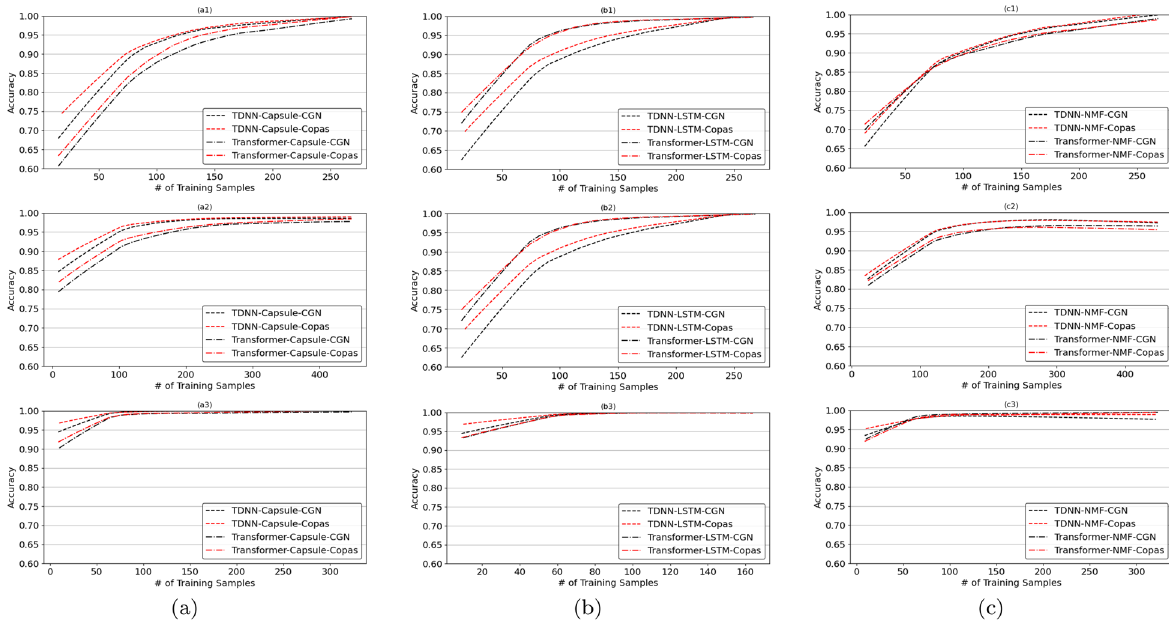
Fig. 9 Average learning curves for different decoders: (a) capsule network, (b) LSTM, (c) NMF. Rows correspond to (1) severely impaired speakers (2) moderately impaired speakers (3) mildly impaired speakers